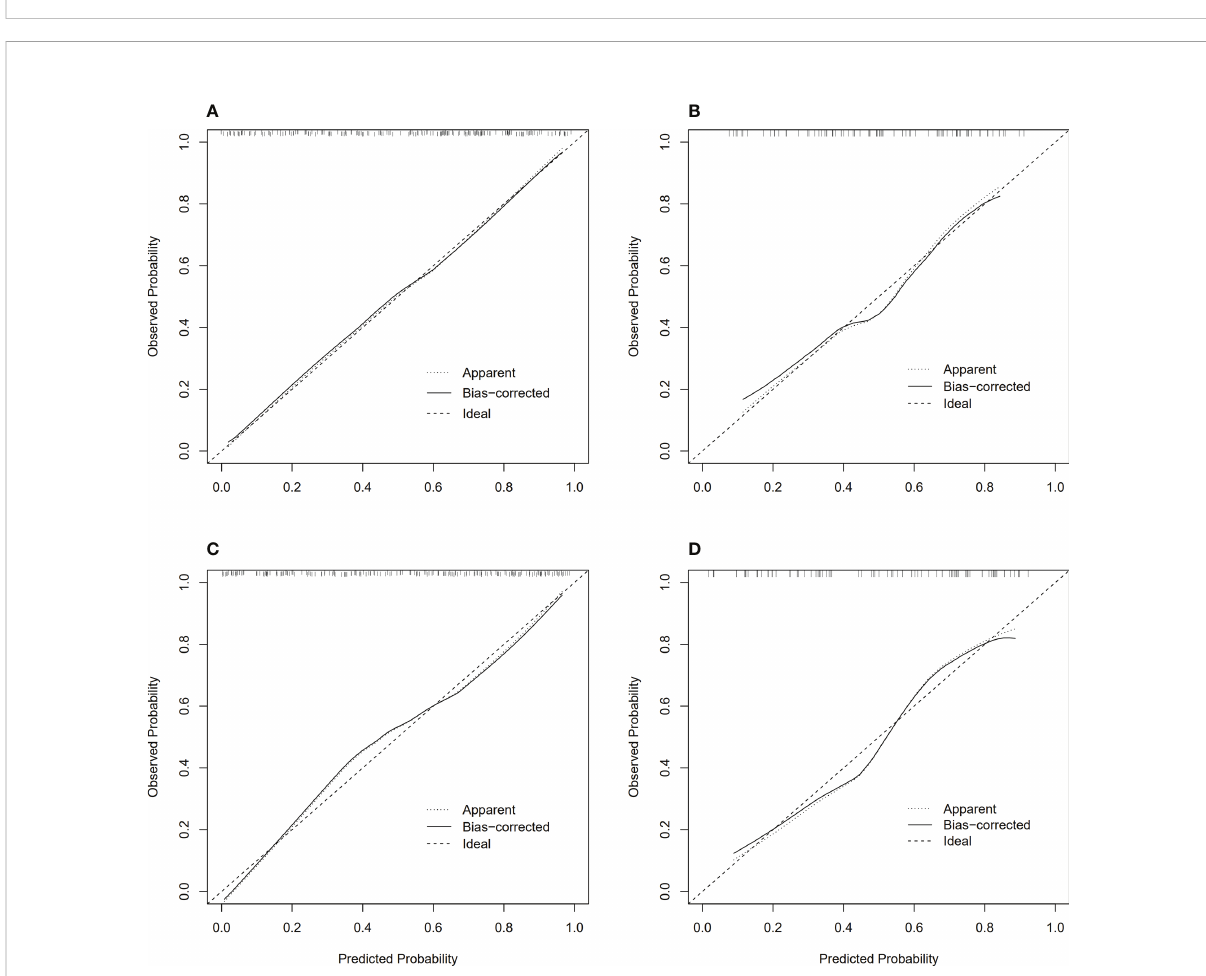
FIGURE 7 Calibration curves of model 2, 3 in training and validation dataset, respectively. (A) Calibration curves of model 2 in training dataset; (B) Calibration curves of model 2 in validation dataset; (C) Calibration curves of model 3 in training dataset; (D) Calibration curves of model 3 in validation